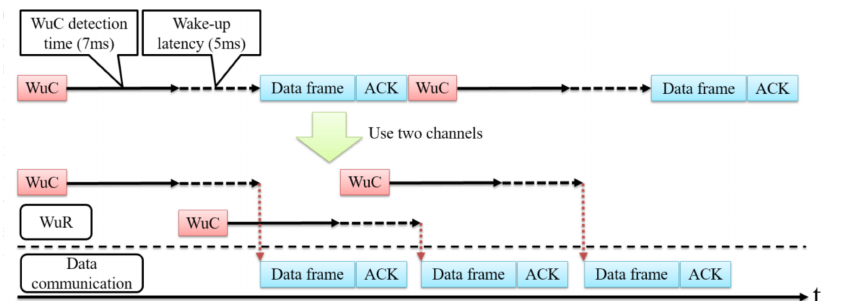
Figure 6. Reducing data collection time by parallel transmission of WuCs and data frames over multiple